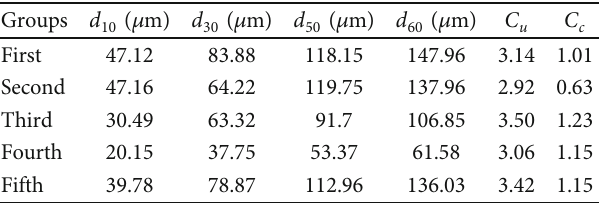
Figure 2: Grain size grading accumulative curve of fi ne-grained tailing sand: (a) the fi rst group; (b) the second group; (c) the third group; (d) the fourth group; (e) the fi fth group. Table 2: Grading constants of tailing sand of di ff erent